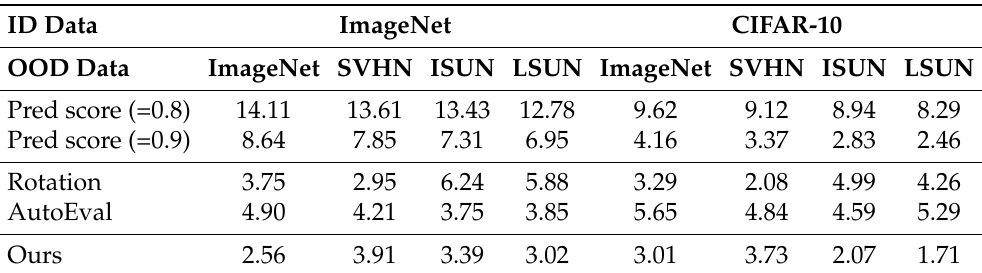
Table 1. Performance of the various methods on eight datasets containing OOD data. These datasets all consist of 90% ID data and 10% OOD